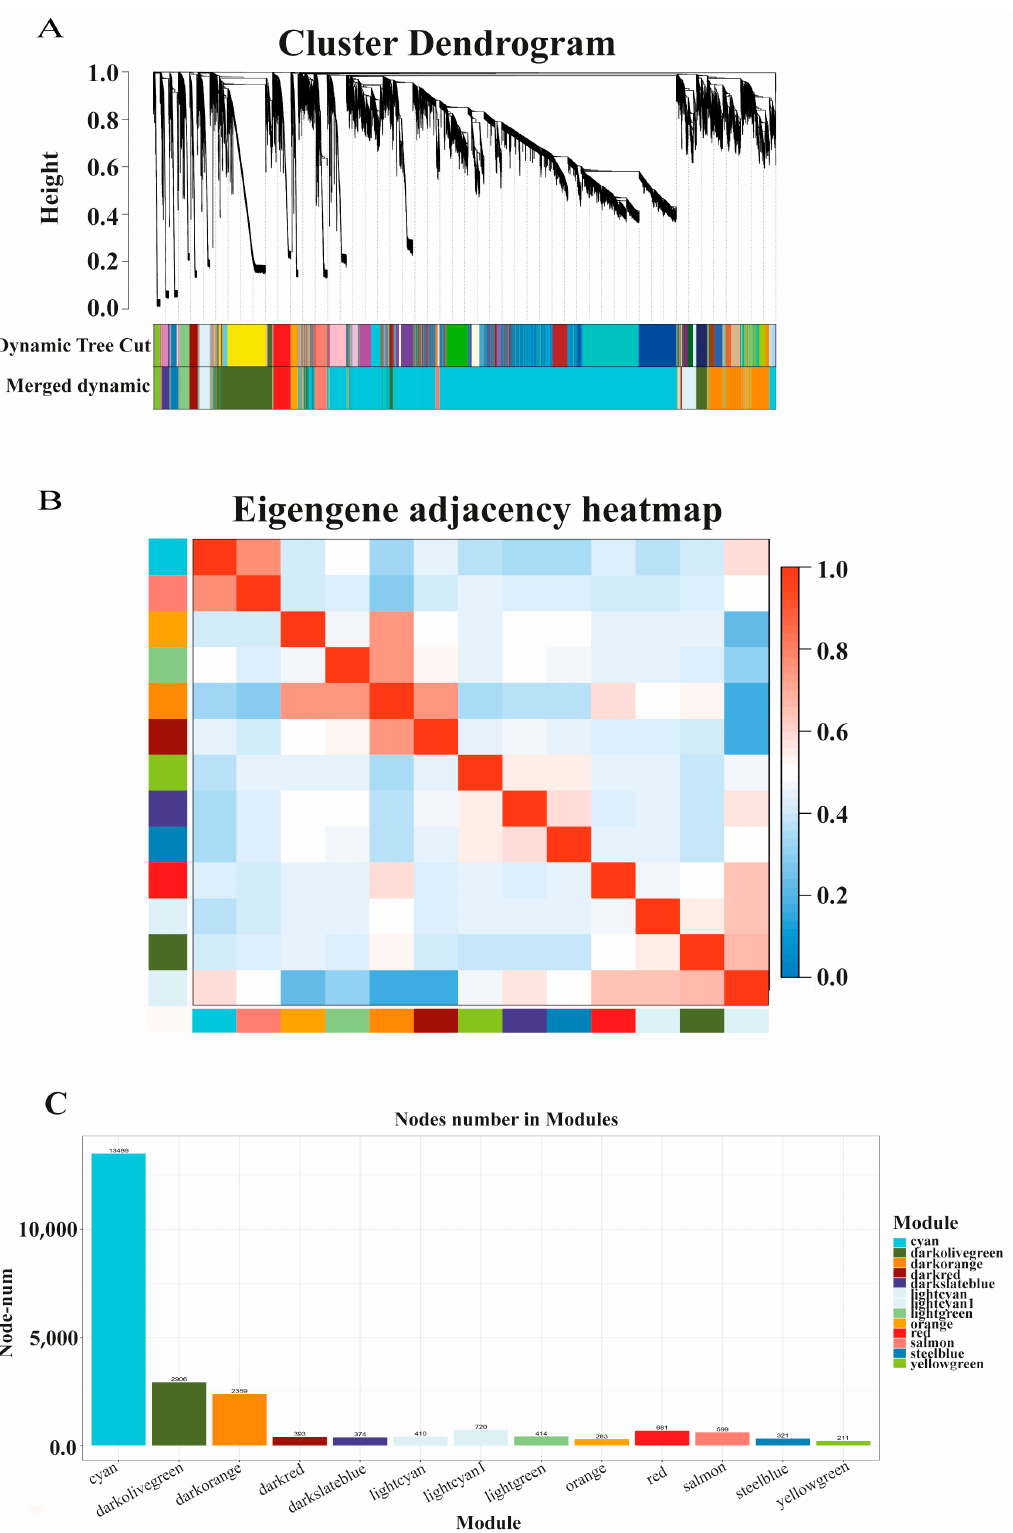
Figure 5. Weighted gene co-expression network analysis (WGCNA). ( A ) Hierarchical clustering dendrogram of lncRNA– mRNA co-expression modules. Each branches represents a cluster of lncRNAs or mRNAs. Dynamic tree cut represents original split module, and merged dynamic represents final merged modules. ( B ) Hierarchical clustering dendrogram of module eigengenes and heatmap of adjacencies using WGCNA; red and blue indicate positive and negative correlation, respectively. ( C ) Number of module genes; histogram represents numbers of lncRNAs or mRNAs in the co-expression module.